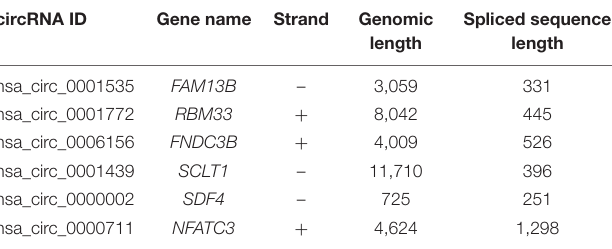
TABLE 2 | Basic characteristics of the top six dysregulated exosomal circular RNAs (circRNAs). circRNA ID